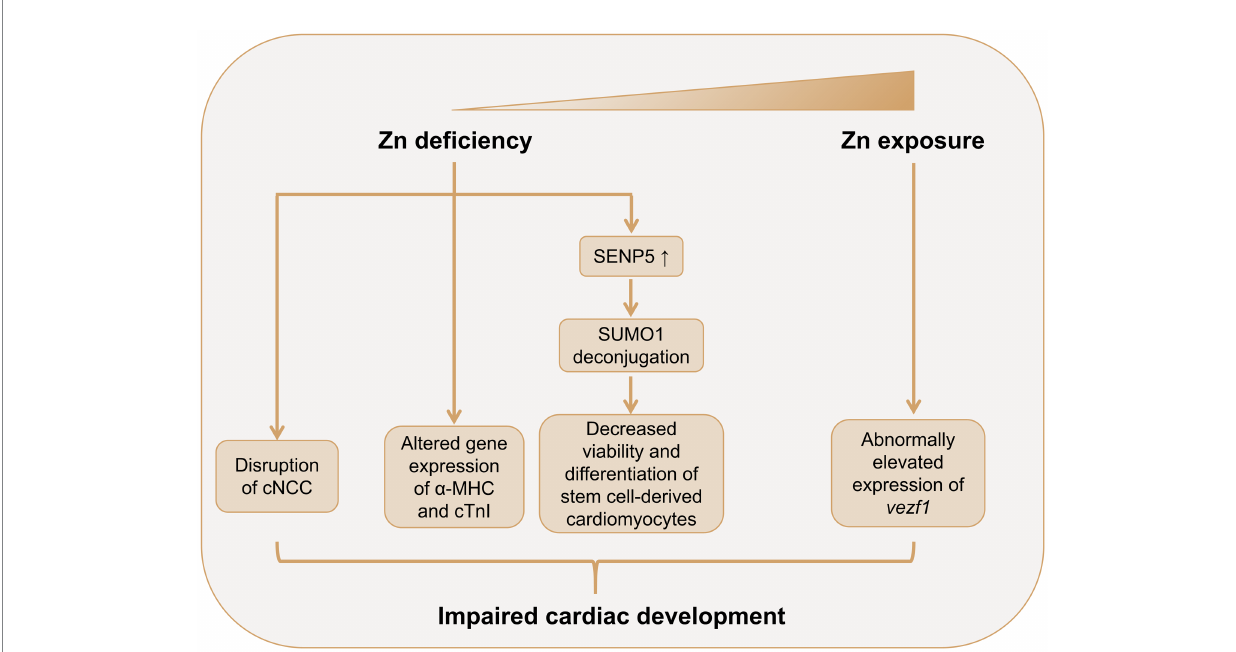
FIGURE 2 Role of Zn in cardiac development. Both Zn deficiency and excessive Zn exposure may lead to abnormal cardiac development. Zn deficiency leads to abnormal amount and distribution of cNCC in the embryonic heart. Zn deficiency alters the gene expression patterns of α -MHC and cTnI in the fetus heart. Zn deficiency also promotes SENP5 overexpression, which deconjugates SUMO1, leading to decreased cell viability and inhibited differentiation of stem cell-derived cardiomyocytes. Zn exposure may induce cardiac abnormalities though promoting the expression of vezf1 in embryonic heart. α -MHC, α -myosin heavy chain; cTnI, cardiac troponin I; cNCC, cardiac neural crest cell; NO, nitric oxide; SENP-5, small ubiquitin-related modifier protein (SUMO)-specific protease 5; SUMO-1, small ubiquitin-related modifier protein 1; vezf1 , vascular endothelial zinc finger 1; Zn,